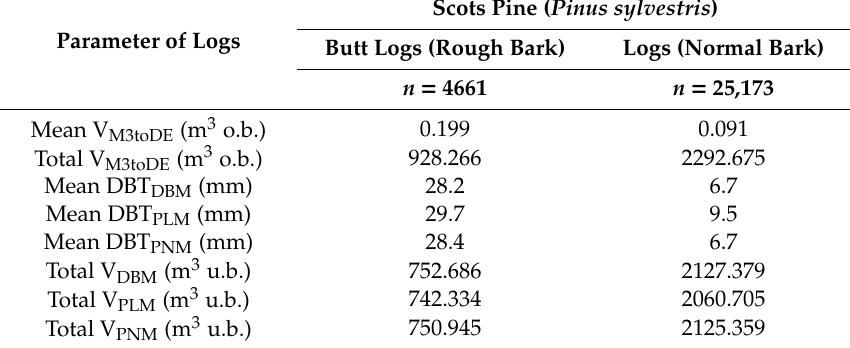
Table 4. Measured Scots pine timber parameters and estimated under-bark volumes, using three different bark deduction methods (DBM, PLM, PNM), for butt logs with rough bark and other logs with normal bark thickness.